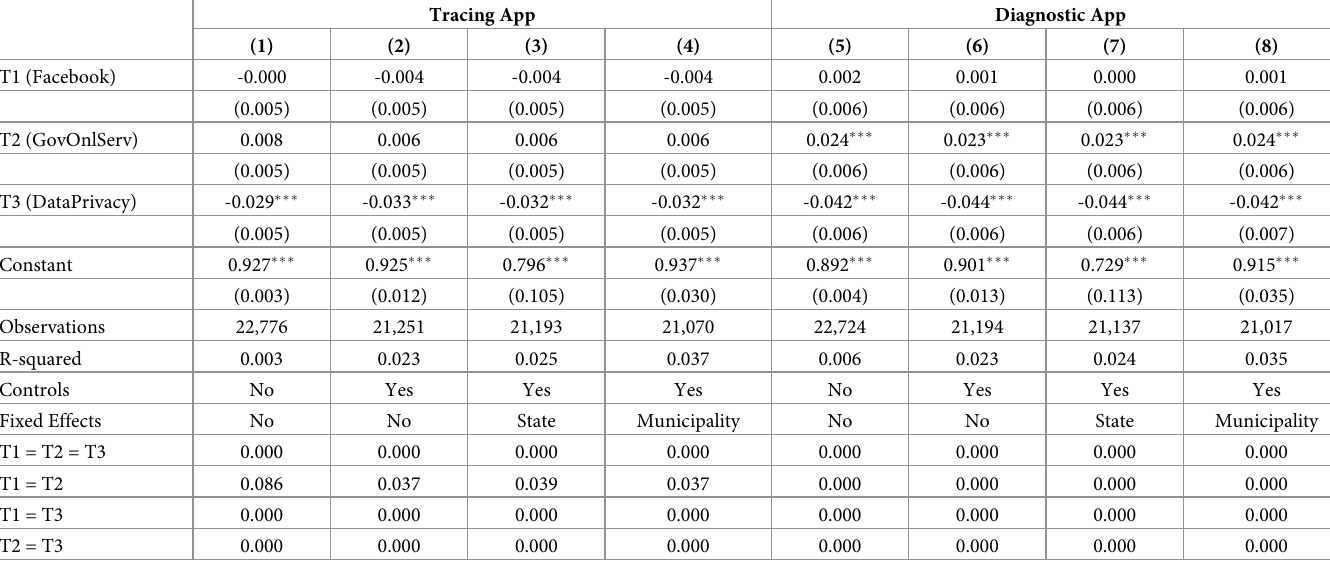
Table 2. Treatment